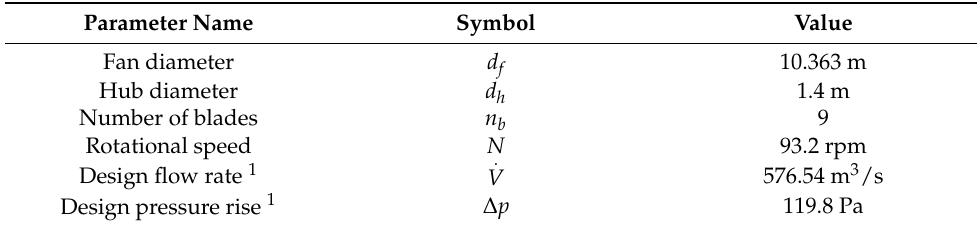
Table 2. Axial fan Table 2. Axial fan specifications.